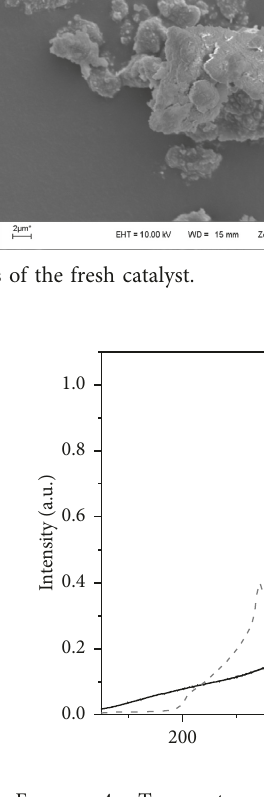
Figure 4: Temperature-programmed reduction experiment: CaO+ZnO oxide mixture (doted line); CaO-ZnO catalyst (con- tinuous